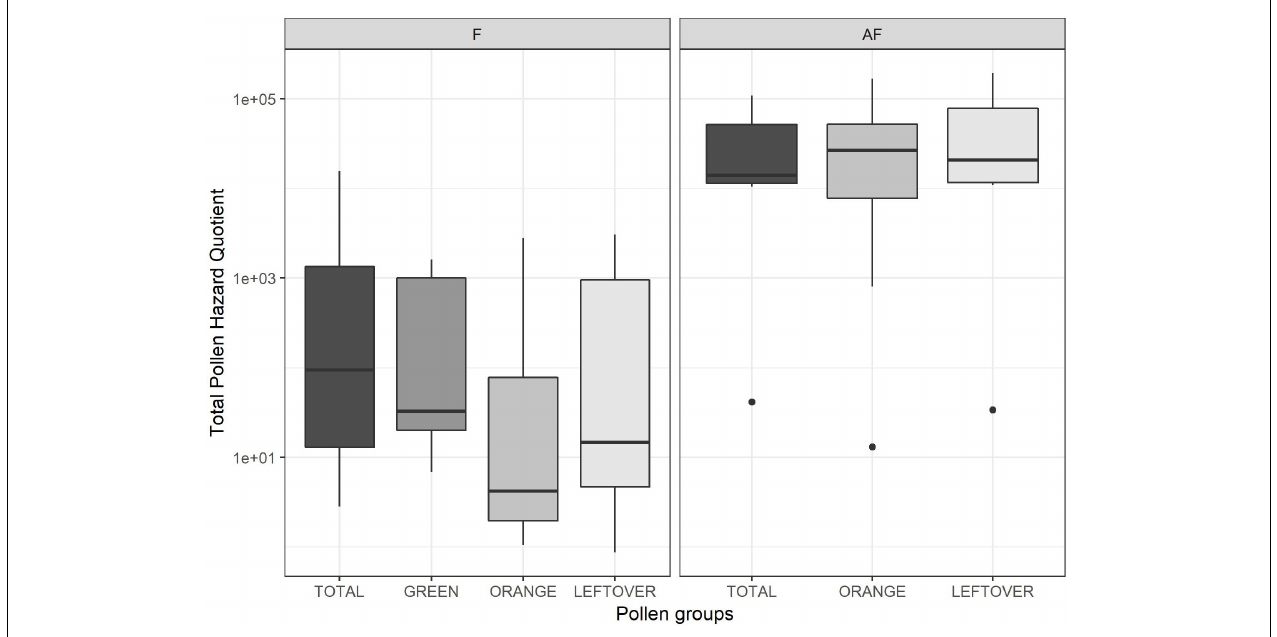
FIGURE 4 | Total Pollen Hazard Quotient (PHQ) of the pesticide residues detected in each sample, during (on the left frame, F) and 2 weeks after apple blossom (on the right frame, AF). Values are reported on a logarithmic scale. Dots indicate outliers.